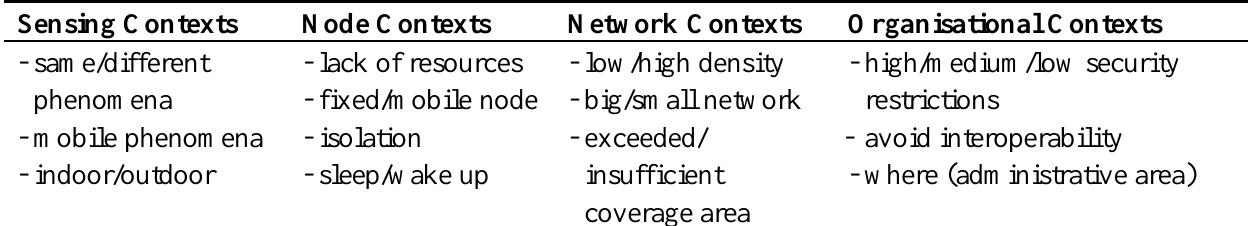
Table 2. The four types of contexts in WSN